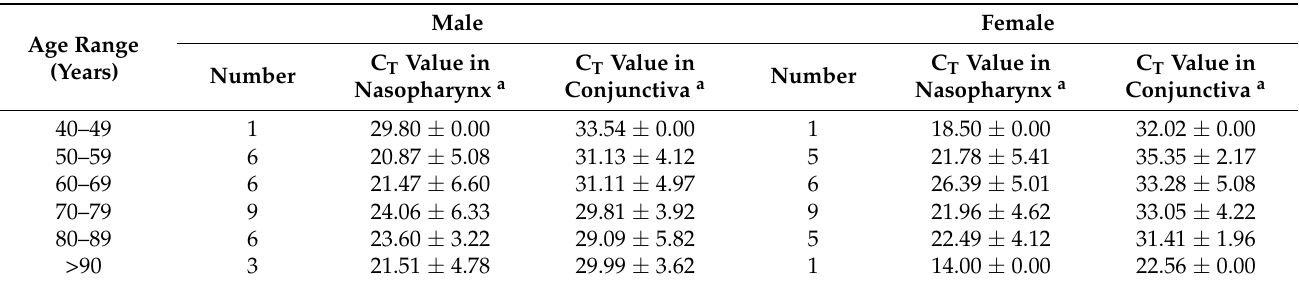
Table 4. The cycle threshold (C T ) values from the group of all patients with a positive result from the conjunctival sac divided by age and